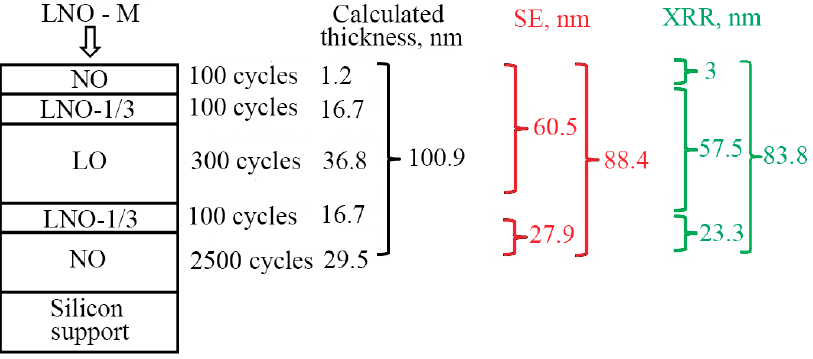
Figure 5. Scheme of deposition of LNO-M sample and thicknesses of the layers determined by spectral ellipsometry (SE) and X-ray reflectometry (XRR).